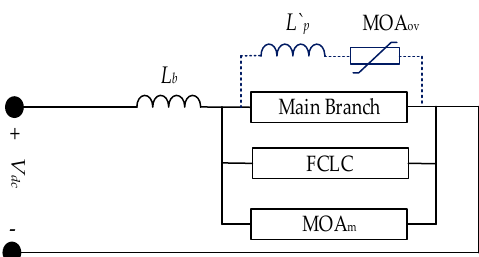
Figure 9. Representing the protection approach for switches in main branch of the HCB with FCLC.